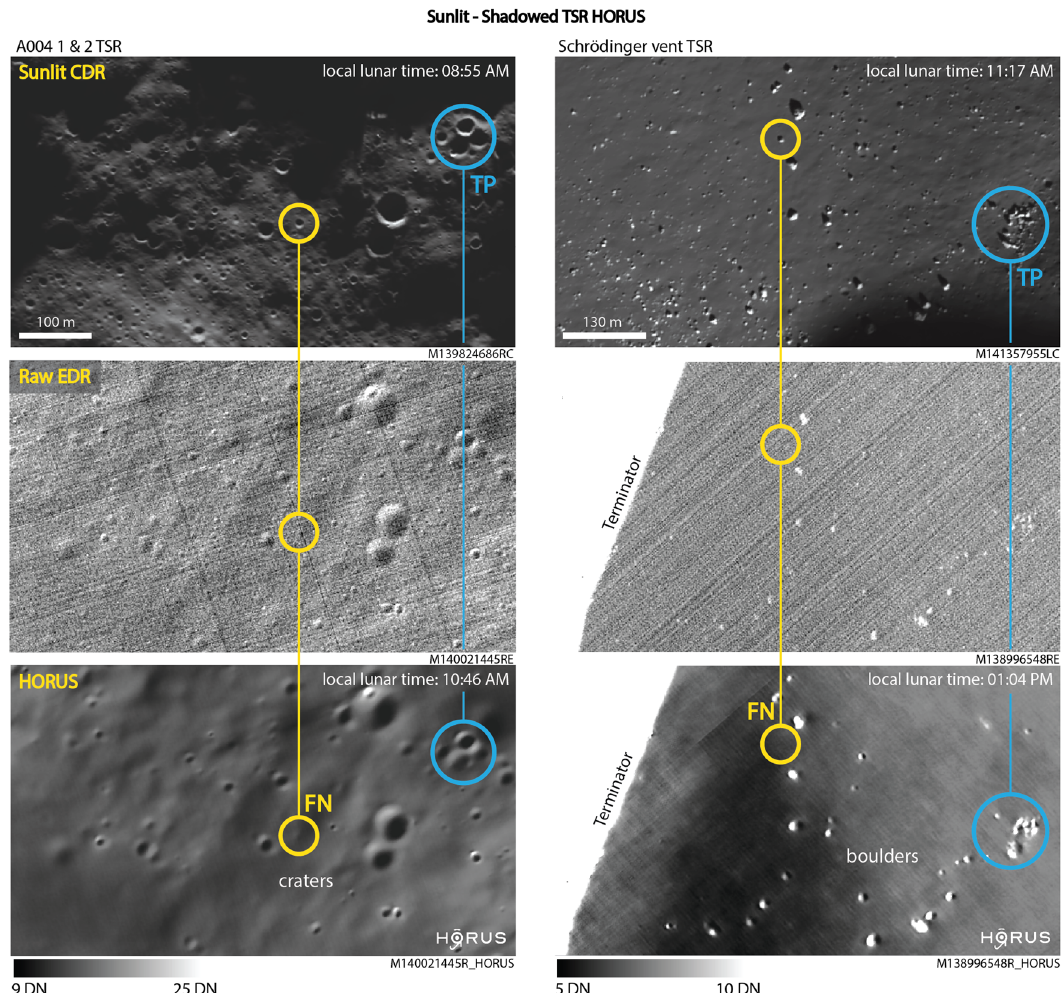
Fig. 3 Transiently shadowed regions validation of HORUS images. Example HORUS images in two different TSRs (transiently shadowed regions); we compare HORUS denoised shadowed images to corresponding shadowed raw NAC EDR (Narrow Angle Camera Experimental Data Record) and sunlit CDR (Calibrated Data Record) images of the same region. We observe that HORUS can image features visible in the corresponding sunlit image down to a certain minimum feature size (TP, true positive, blue). Features that are smaller than this appear faint or do not appear in HORUS at all (FN, false negative, yellow). This minimum size depends strongly on the photon count (digital number, DN). In the examples above, the smallest resolved crater diameter is ~5 m and the smallest resolved boulder diameter is ~4 m. We do not observe false positives other than residual noise. Raw NAC image credits to NASA/